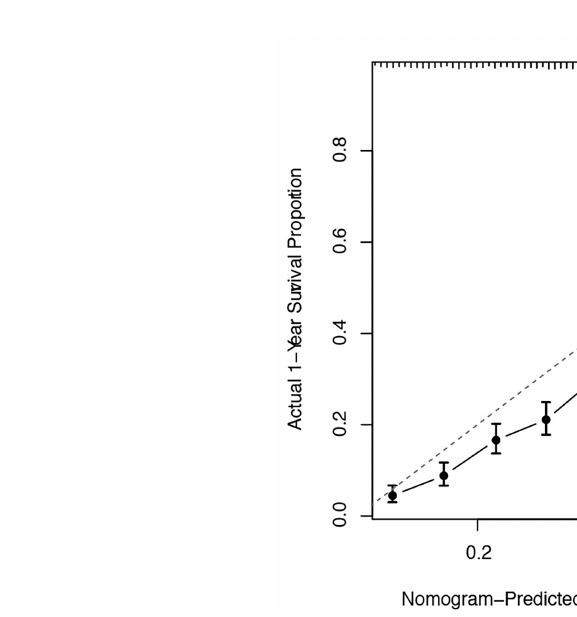
FIGURE 5 | Calibration plots of the nomogram for 1-year and 2-year prediction for OS of CLM patients. OS, overall survival; CLM, colon cancer liver metastases.